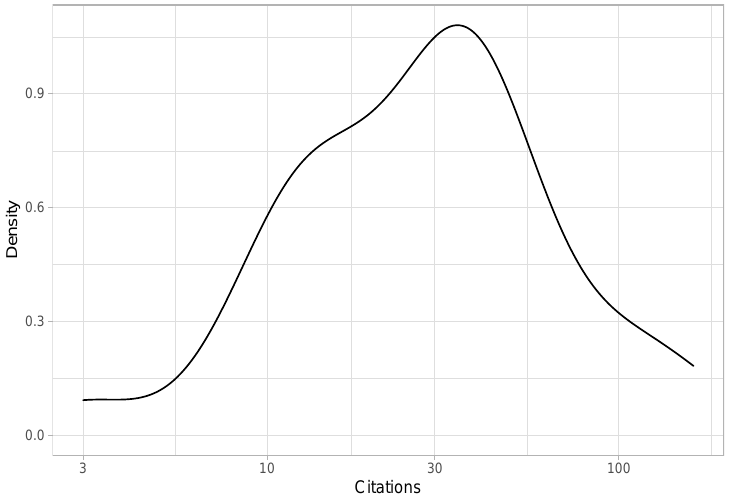
Figure 1. Density plot for five-year citation counts distribution, logarithmic